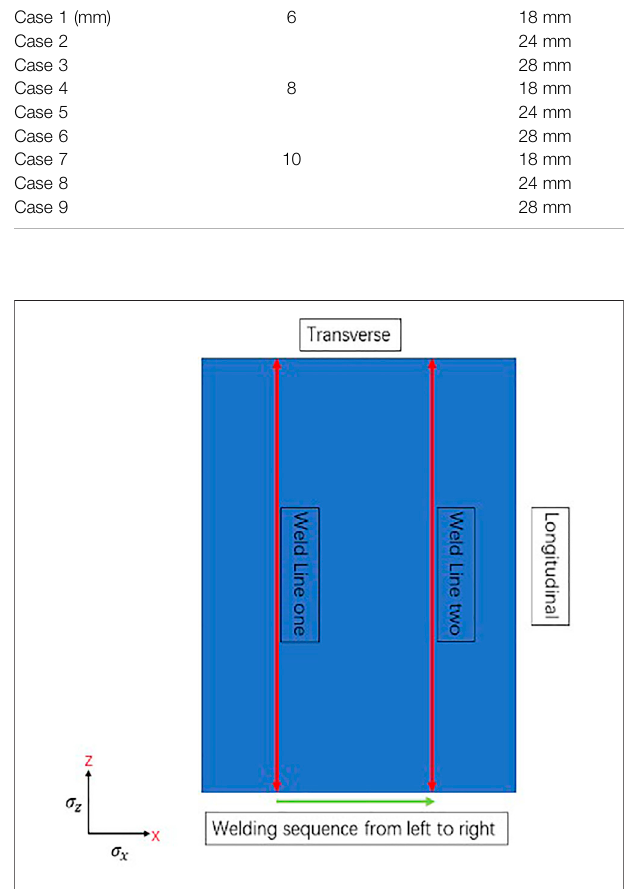
FIGURE 8 | Residual stress σ x along the x -direction (t1 = 8